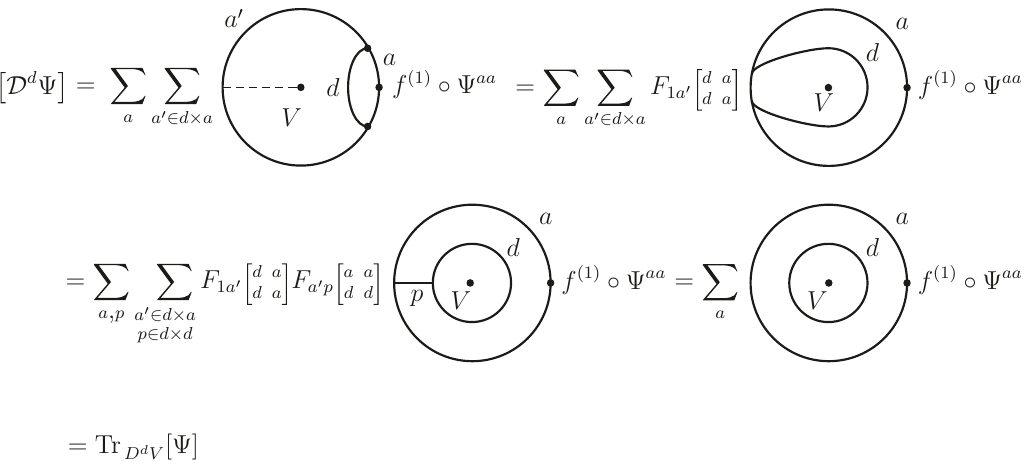
2 1+ iz . Notice that thanks to the junction 1 − iz (cid:17) (cid:16)